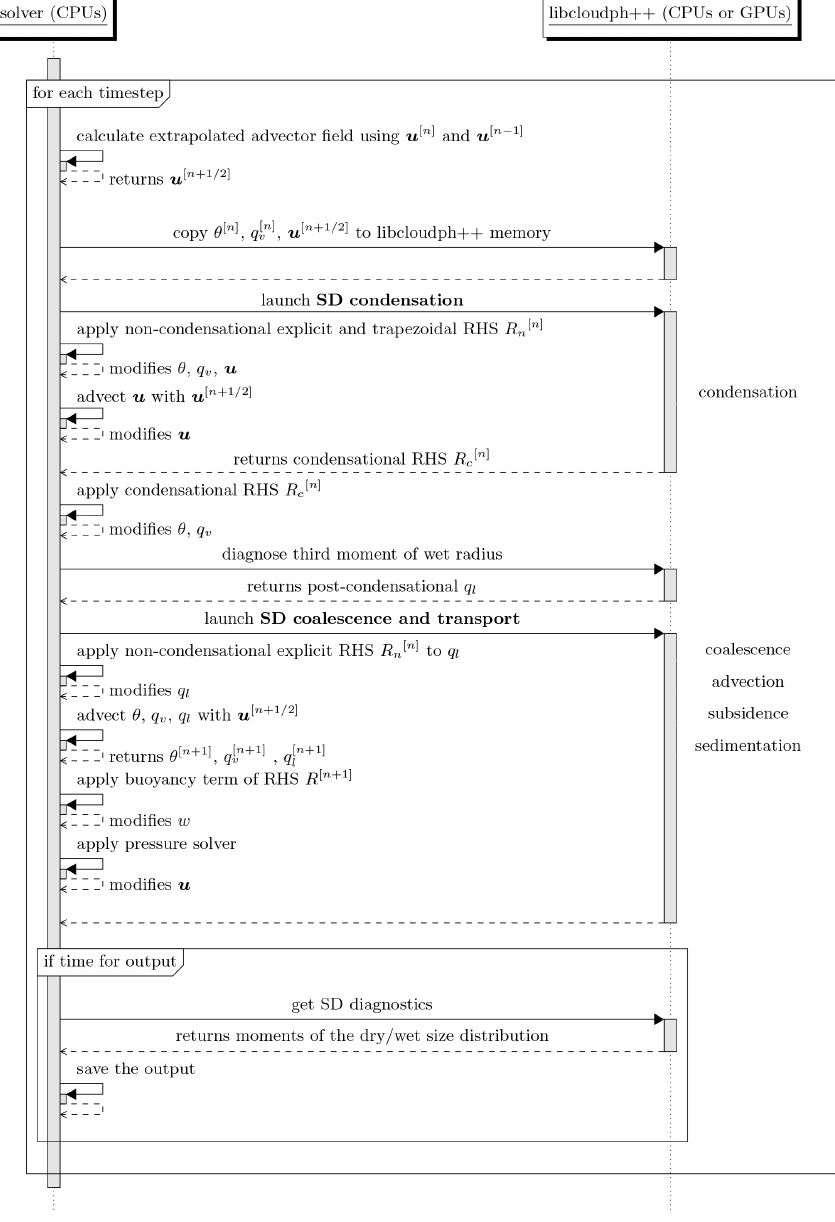
Figure 1. UML sequence diagram showing the order of operations within a single time step. Calls in boldface start microphysical calculations that are carried out on GPUs simultaneously with solver operations undertaken on CPUs. The RHS is divided into condensational and non- condensational parts, R = R n + R c